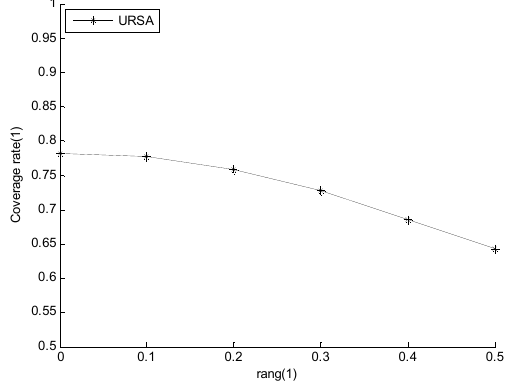
Figure 10. Network coverage rate of the radius-adjusting self-deployment algorithm (URSA) for varying rang .